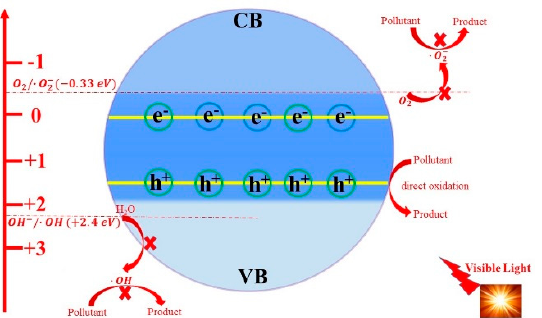
Figure 6. Possible mechanism of photocatalytic degradation of MO solution over KSb 5 S 8 under visible light.